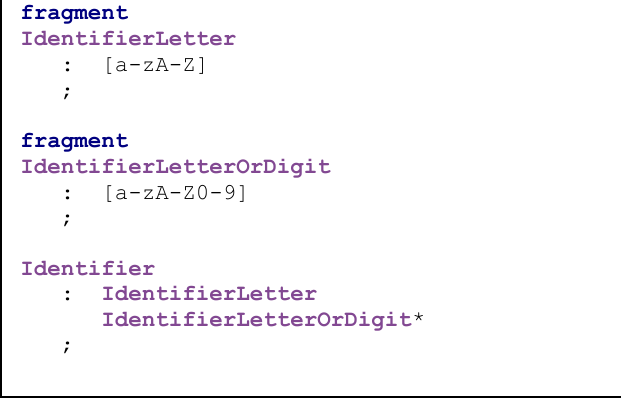
Fig. 7. Identifier construction defined in